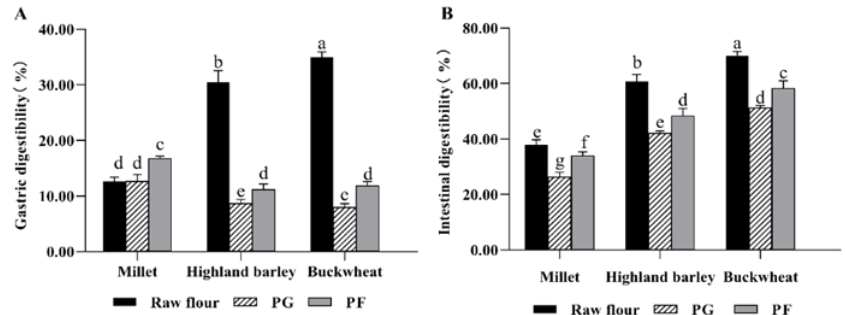
Figure 2. In vitro protein digestibility in ( A ) gastric and ( B ) intestinal phases of cereal-based foods produced by millet, highland barley and buckwheat. PG, cereal-based foods produced using grains (cooked grains); PF, cereal-based foods produced using flour (millet steamed buns, highland barley noodles and buckwheat noodles, respectively). Different letters on the top of the bars (mean ± SD, n = 3) represent significantly different ( p < 0.05).